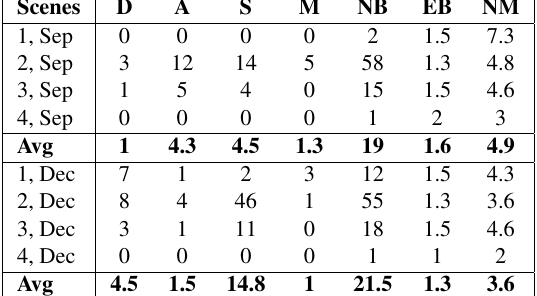
Table 6: Estimation of manual interactions to generate map using automatically extracted buildings. D = number of deletions for removing false buildings (trees), A = number of additions for in- clusion of missing true buildings, S = number of split operations, M = number of merge operations, NB = number of detected build- ings being edited to be acceptable, EB = number of editions per edited building and NM = number of mouse clicks per edition.